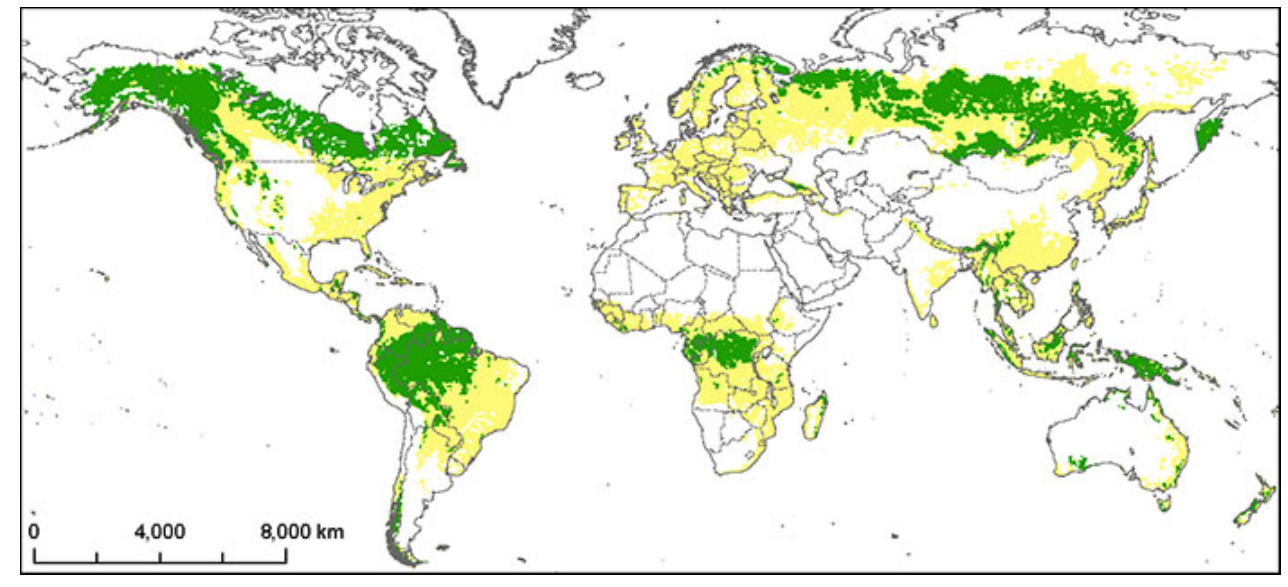
Fig. 2. The world’s intact forest landscapes (IFLs): IFL (green), Forest zone outside IFL